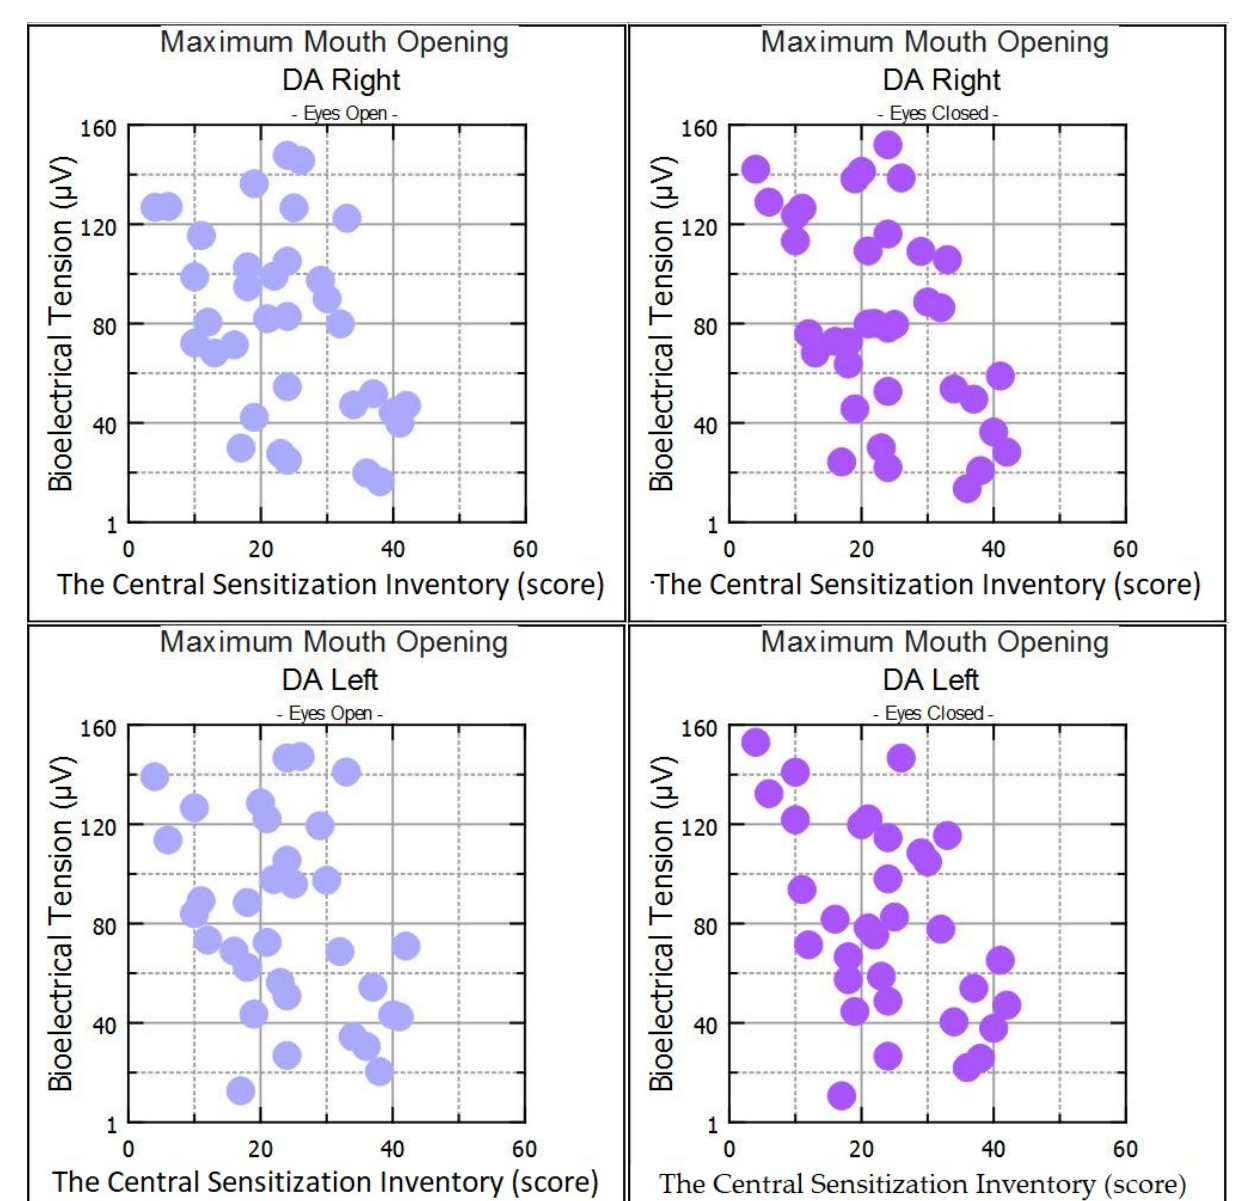
Figure 2. Scatter plot for SCM-R in rest for open eyes and closed eyes.